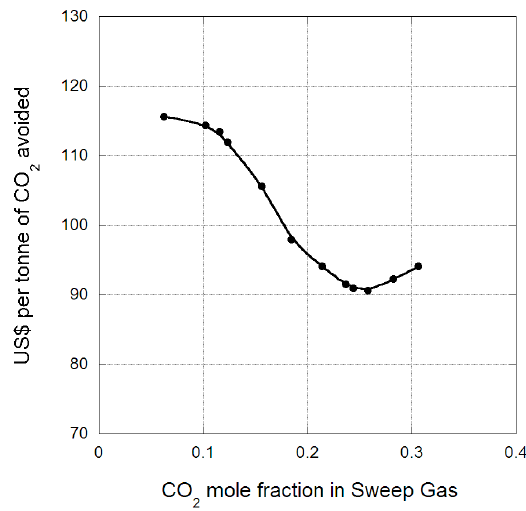
Figure 2. Cost of capture (US$ per tonne of CO 2 avoided) for NGCC as a function of recycle CO 2 mole fraction.